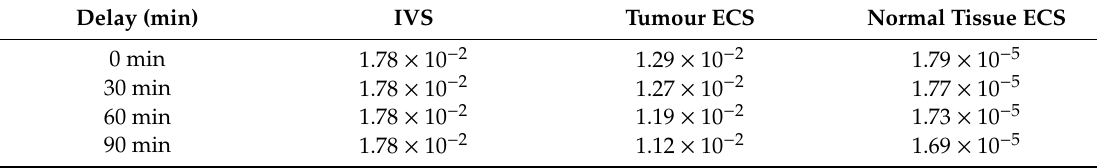
Table 6. AUC 24h (mg/mL·s) of the treatments with different BBBD timings.